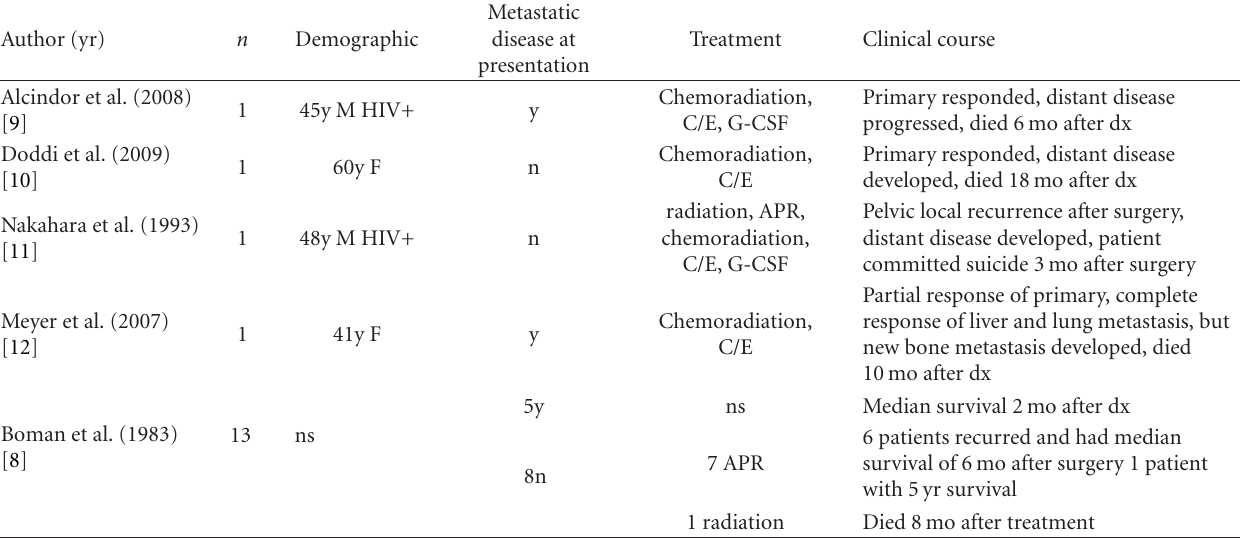
Table 1: Summary of reported cases of anal canal